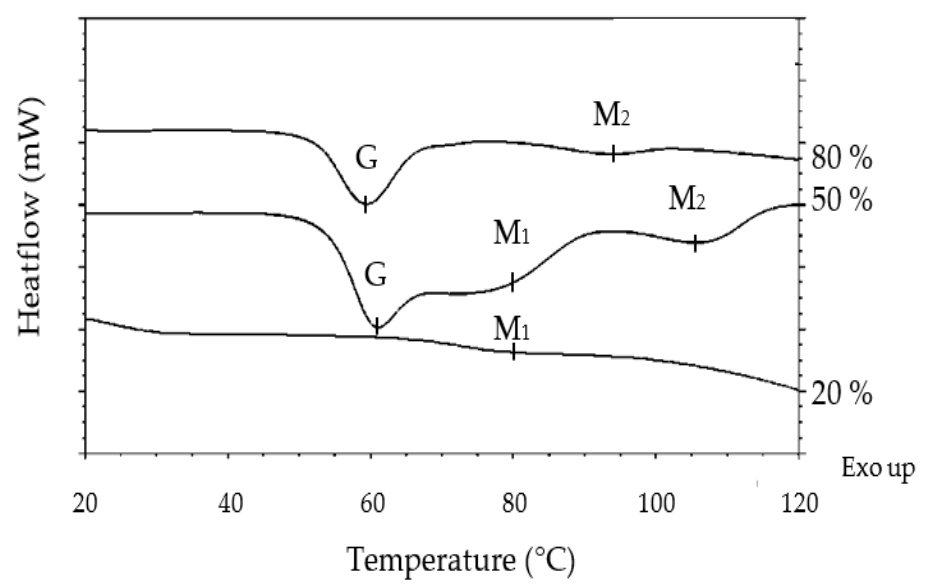
Figure 8. Representative DSC thermograms of flour-water mixtures at different water contents. Thermograms are offset for clarity.